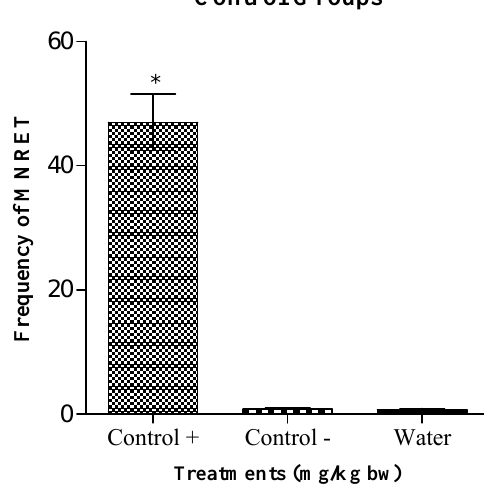
Figure 3. Average frequency of micronucleated reticulocytes (MNRET) and standard deviation of 1000 cells from mice treated with the positive control cyclophosphamide (100 mg/Kg), CMC / Tween (negative control) and water (control white). * P <